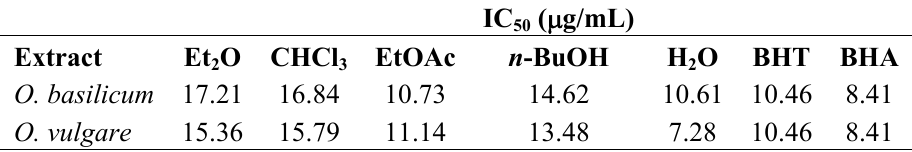
Table 4. IC values ( μ g/mL) of the neutralization of O 50 O. vulgare extracts.